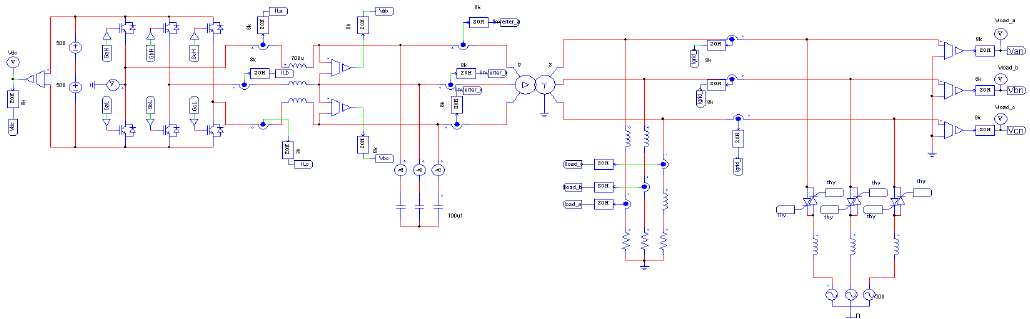
Figure 10. Simulation circuit using Powersim (PSIM).